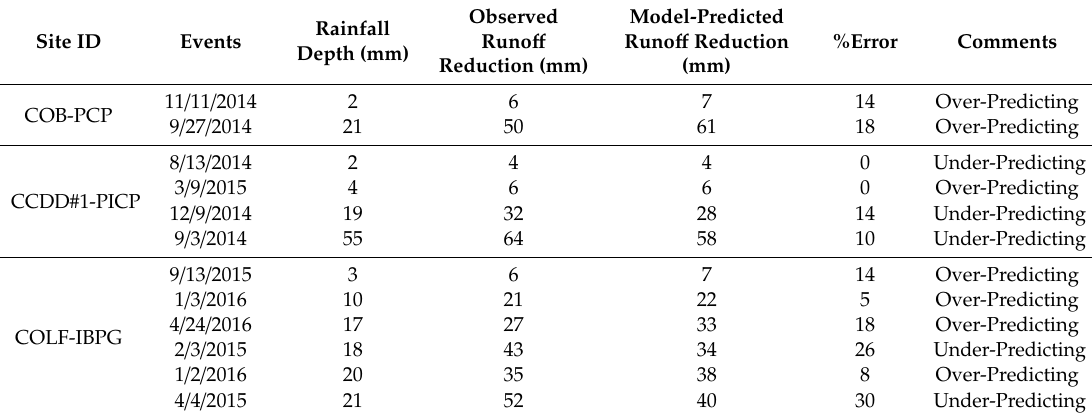
Table 4. Validation results of calibrated WinSLAMM models for three di ff erent types of monitored permeable pavements under the LRGV low-impact development (LID) implementation